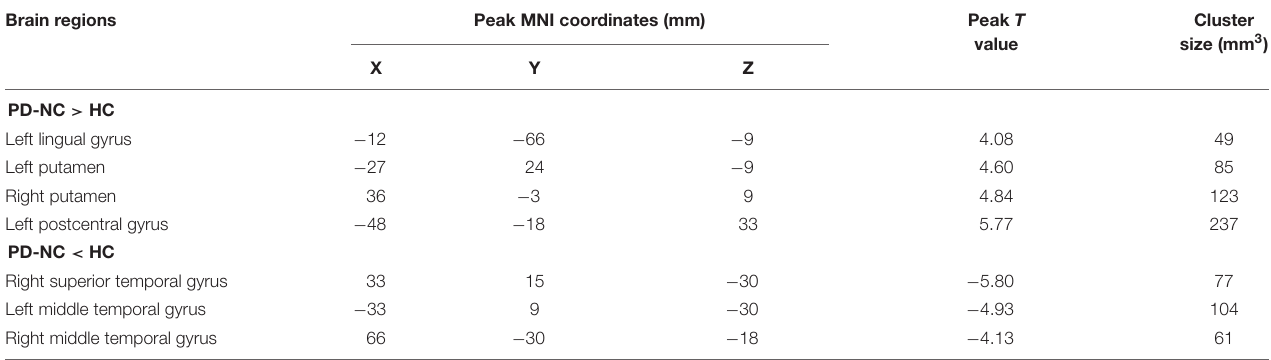
TABLE 3 | Descriptions of significantly different brain regions in the CBF-ReHo ratio between HC and PD-NC groups. Brain regions